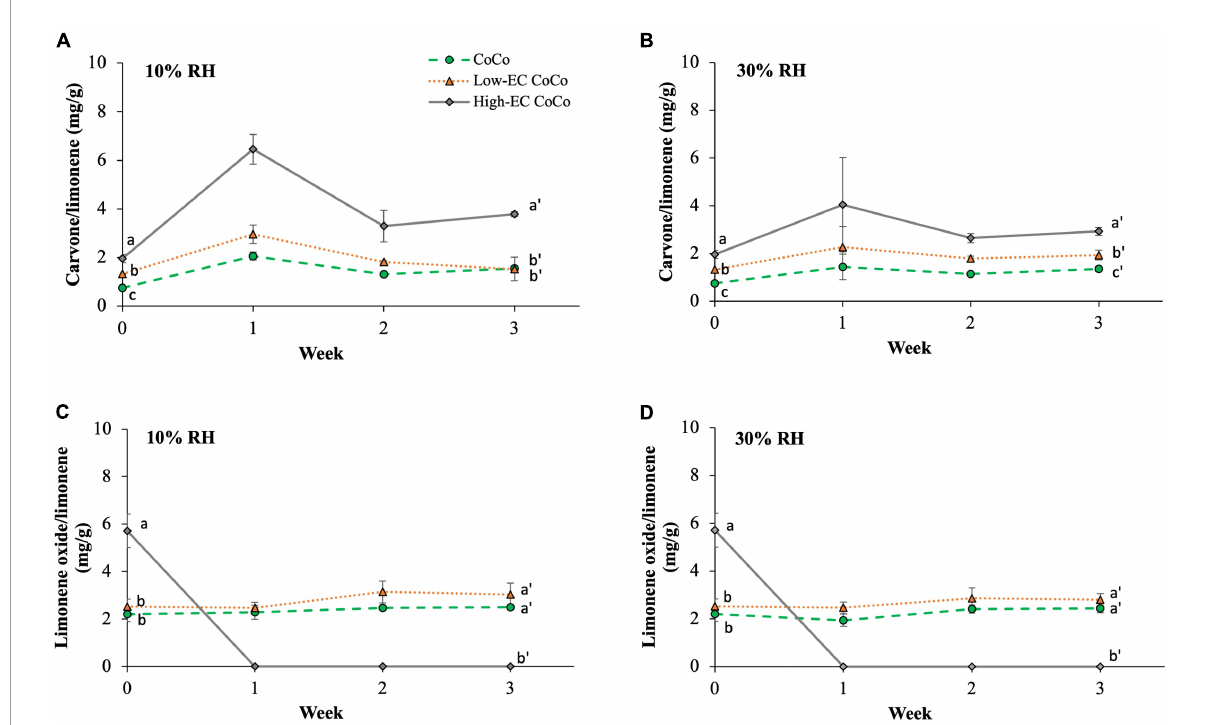
FIGURE5 The carvone (A,B) and limonene oxide (C,D) contents in microcapsules stored at 10% RH condition (A,C) and ambient (30% RH) conditions (B,D) . The carvone and limonene oxide contents in microcapsules stored at 75% RH is not shown because it was below the detection limits. Lines are drawn to guide the eye. Different letter indicates statistically significant differences between different formulations at selected time